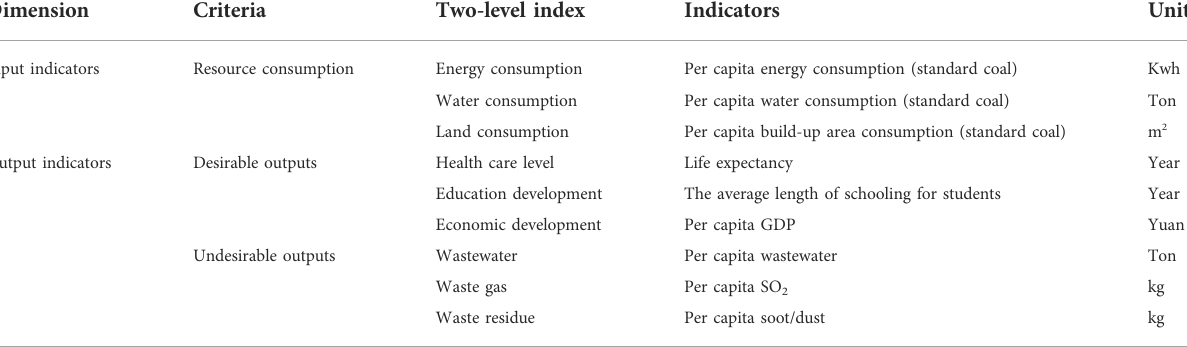
TABLE 1 The input and output indexes.